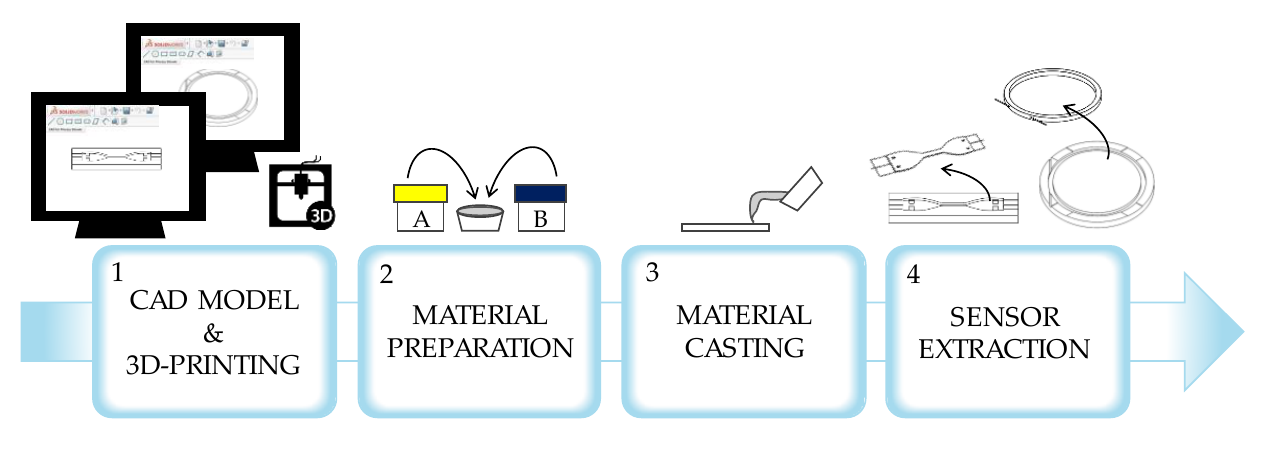
Figure 3. Main steps of the fabrication process.